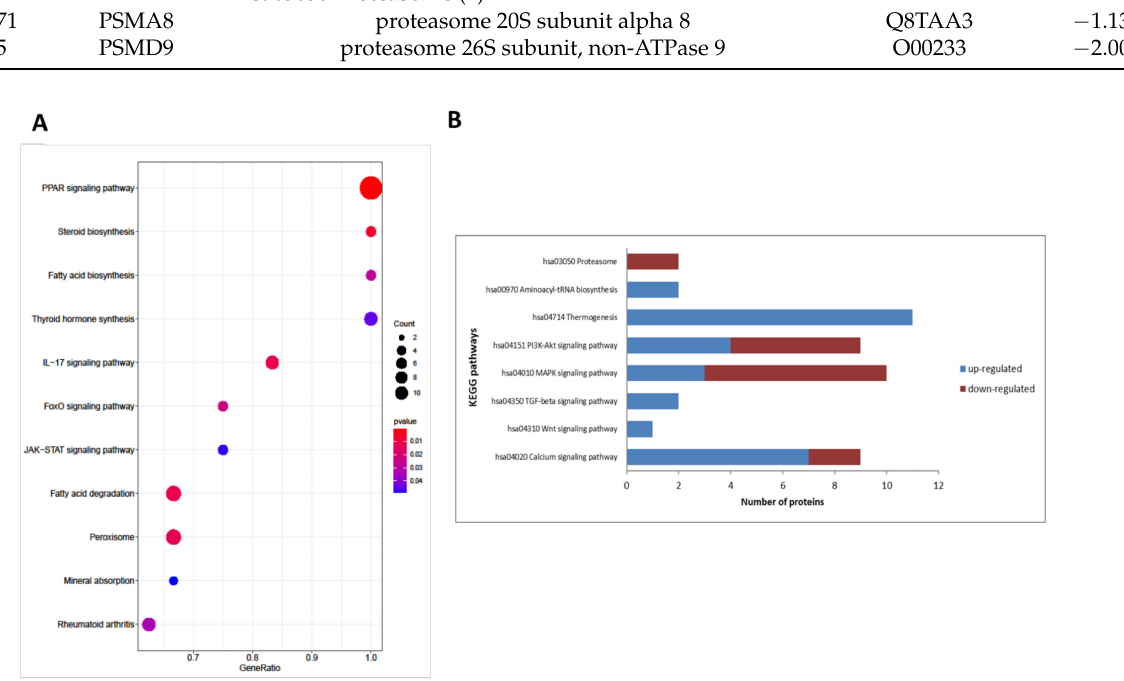
Figure 5. KEGG pathway analysis. Dot plot ( A ) of enriched KEGG pathways (results from ClusterProfiler) produced by enrichplot Bioconductor package. The color of the dots represents the p -value, the size of the dots represents the number of differentially abundant proteins. Column chart ( B ) of KEGG pathway with a known role in osteogenesis. Specific proteins belonging to these functional groups are detailed in Table